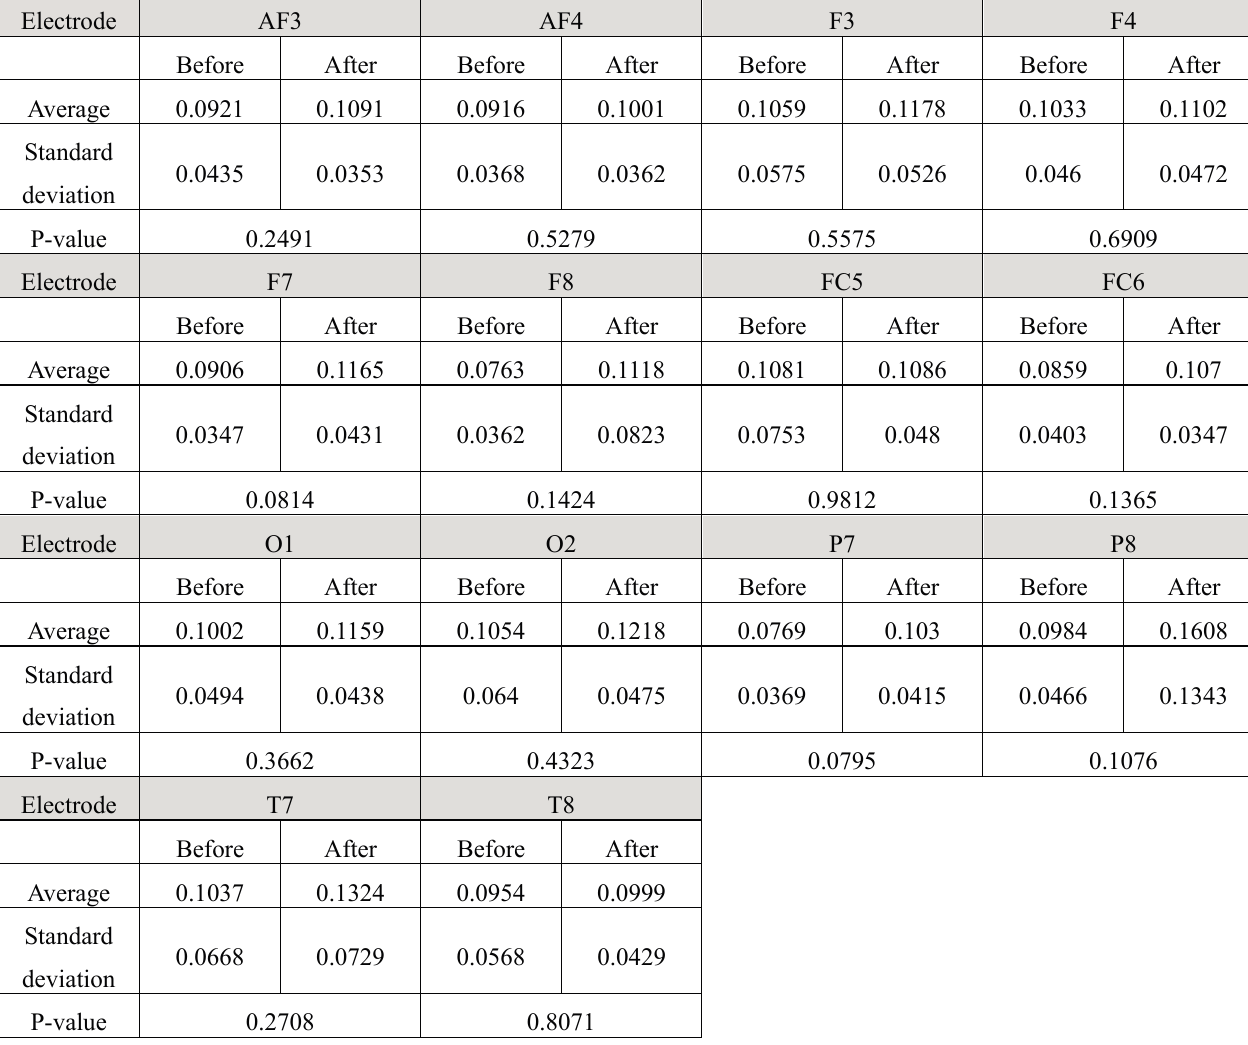
Table 4. The average and standard deviation of the EEG